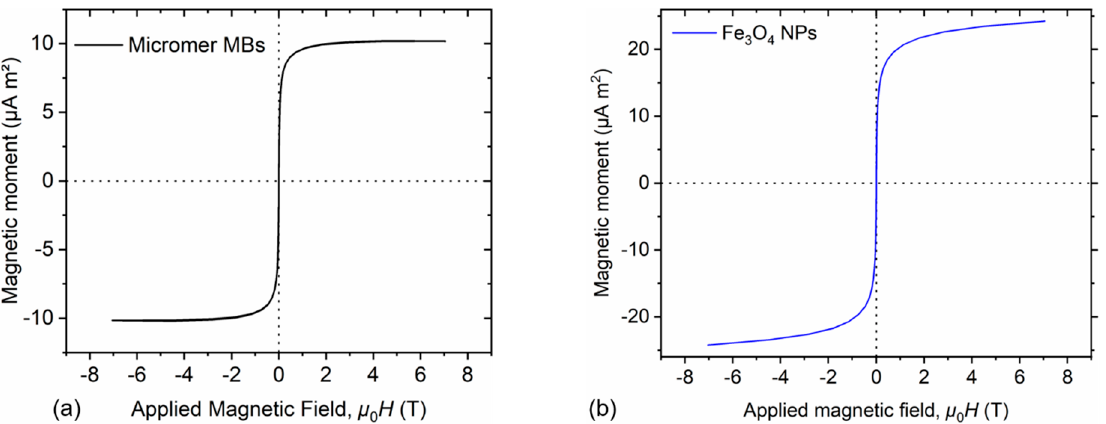
Figure 10. Total magnetic moment versus applied magnetic induction field ( B = µ 0 H , spanning from –7 T to 7 T) for: ( a ) Magnetic polystyrene beads (2 µ m in size), and ( b ) iron oxide NPs (250 nm in size). The sinusoidal magnetic induction field was applied under a stable temperature environment (300 K).